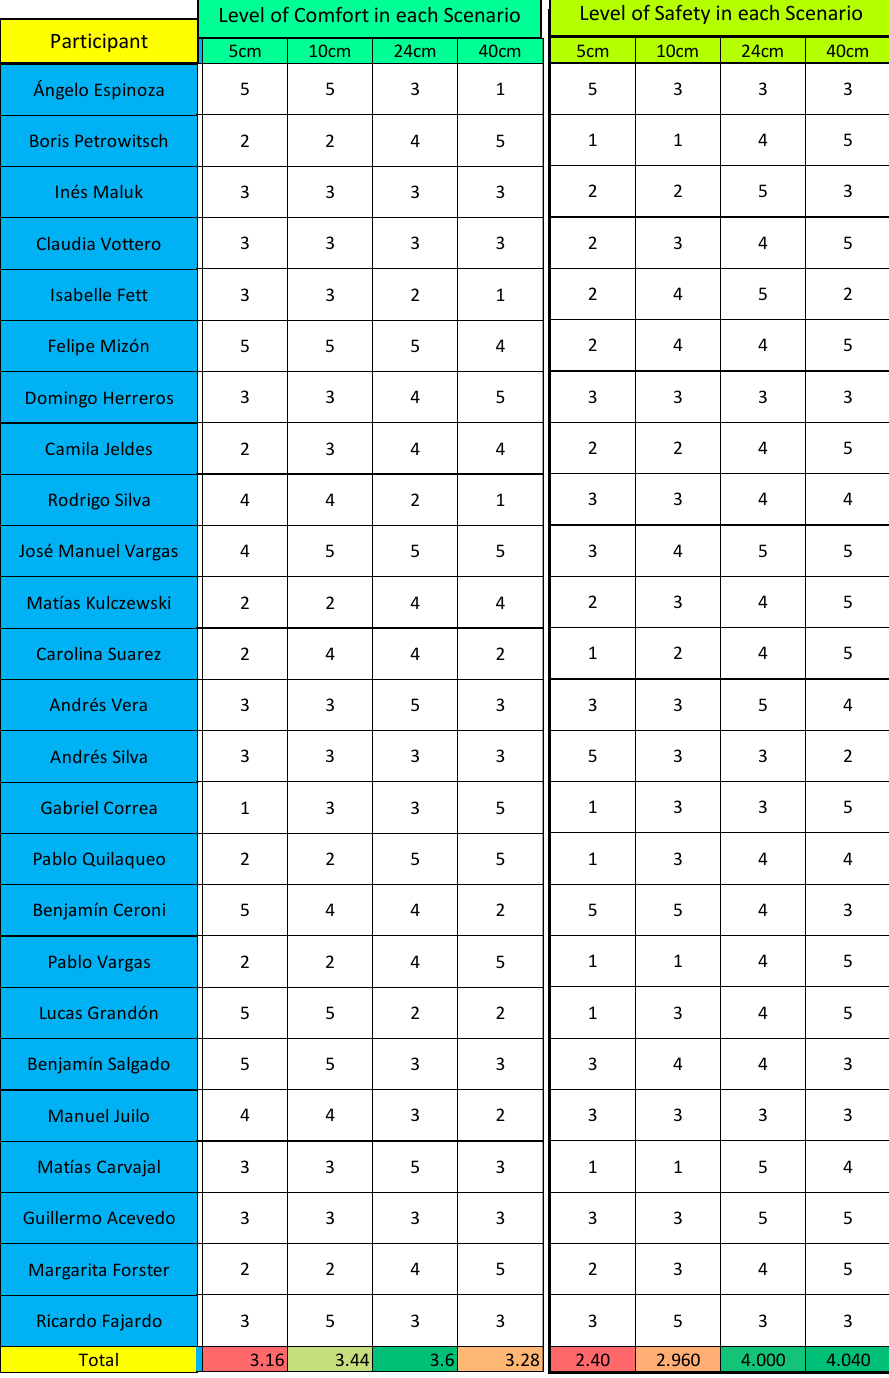
Figure 5. Results from the survey questionnaire to each of the volunteers who participated in the experiments in each yellow-safety-line scenario.